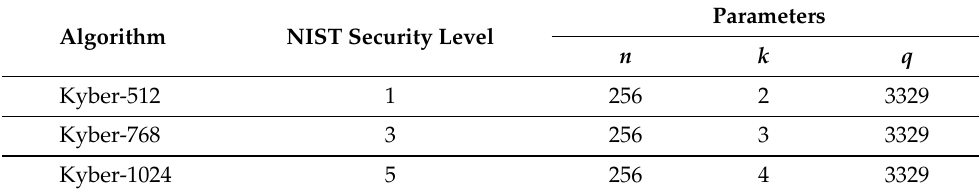
Table 1. Kyber parameter sets